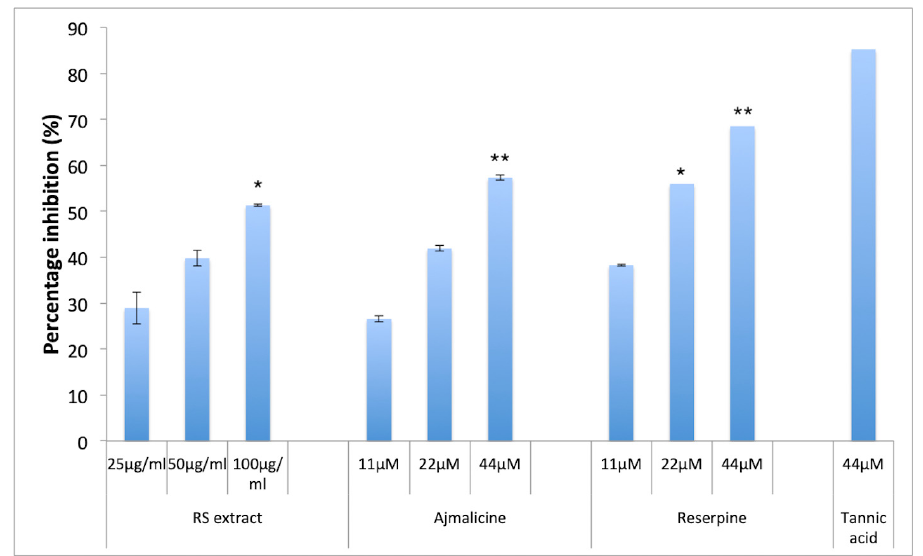
Figure 5. Percentage inhibition of A β 42 aggregates formation; RS— R.serpentina extract (100, 50, 25 μ g/mL); AJM—Ajmalicine (44, 22, 11 μ M); RES—Reserpine (44, 22, 11 μ M); NC—PC12 cells treated